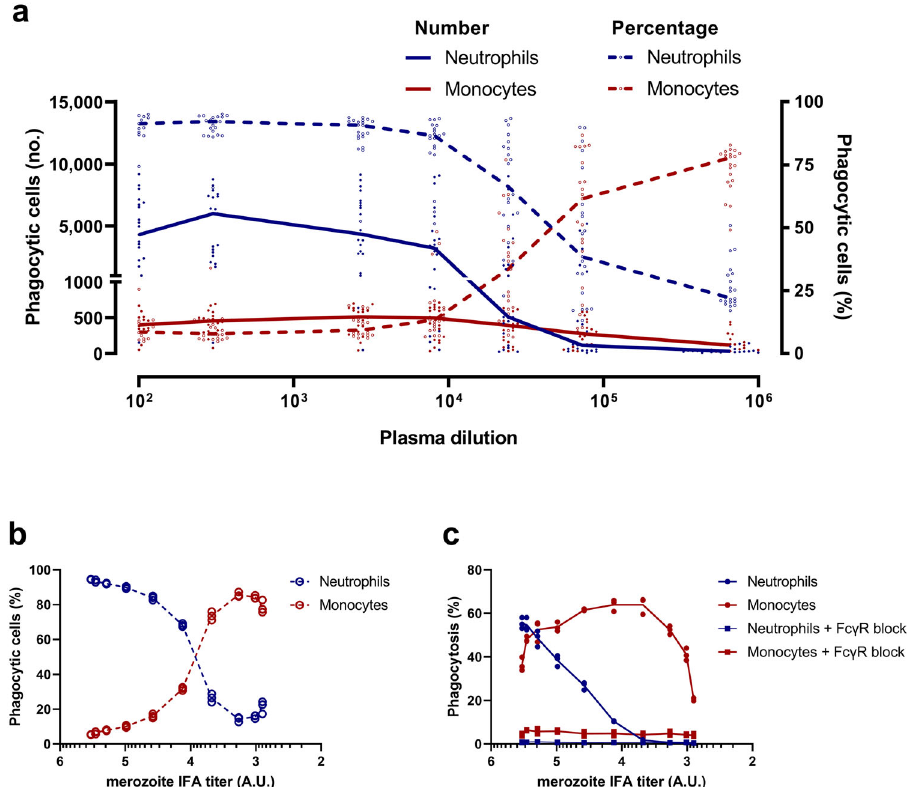
Fig. 2 Merozoite-phagocytosis by PBLs depends on the degree of antibody opsonization. Merozoites were opsonized with serial dilutions of individual plasma ( n = 21) from Ghanaian children a or a pool of the same plasma b and c and incubated with PBLs (6 × 10 4 per well) for 30 min at 37 °C for phagocytosis to occur. Cells were stained with anti-CD14, CD16, CD45, and CD66b antibodies and analyzed by fl ow cytometry to enumerate EtBr-positive cells. a Left y -axis shows the median number (no.) of EtBr-positive neutrophils (blue solid line) and monocytes (red solid line) present in PBLs in the presence of individual plasma samples ( n = 21). Right y -axis shows the median percentage of EtBr neutrophils (dotted blue line) and monocytes (dotted red line) in EtBr-positive PBL fraction in the presence of individual plasma samples ( n = 21). b Mean percent of EtBr-positive neutrophils and monocytes in EtBr-positive PBL fraction in the presence of pooled plasma is plotted against the amount of antibody deposited on the merozoite surface as quanti fi ed by the merozoite-immuno fl uorescence assay (IFA). c Mean percentage of EtBr-positive neutrophils and monocytes present in PBL preparations either untreated or pretreated with Fc γ R blockers in the presence of pooled plasma is plotted against merozoite-IFA. The experiments in b and c were performed in